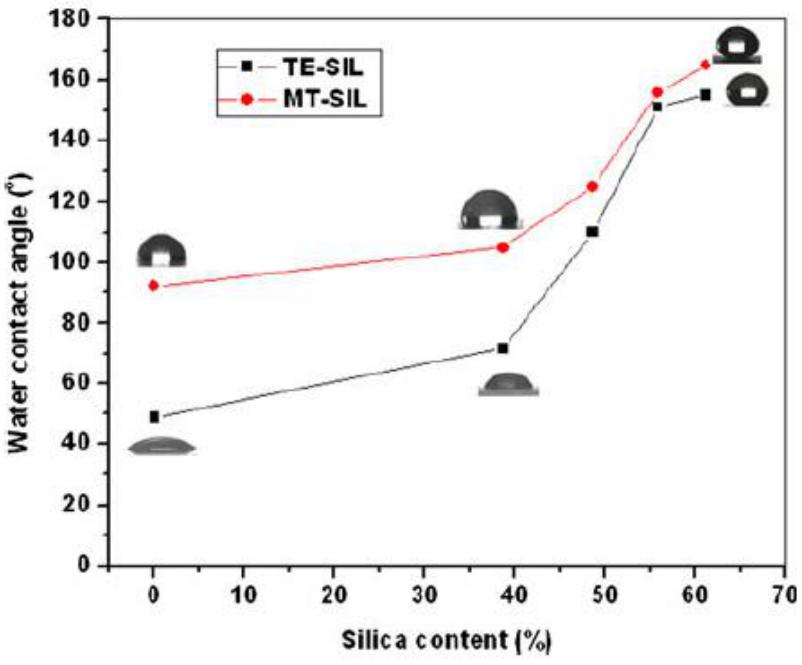
Figure 6. Effect of the concentration of hydrophobically modified silica nanoparticles on the water contact angle of sol – gel composite coatings prepared with sols of TEOS and MTES. Reproduced